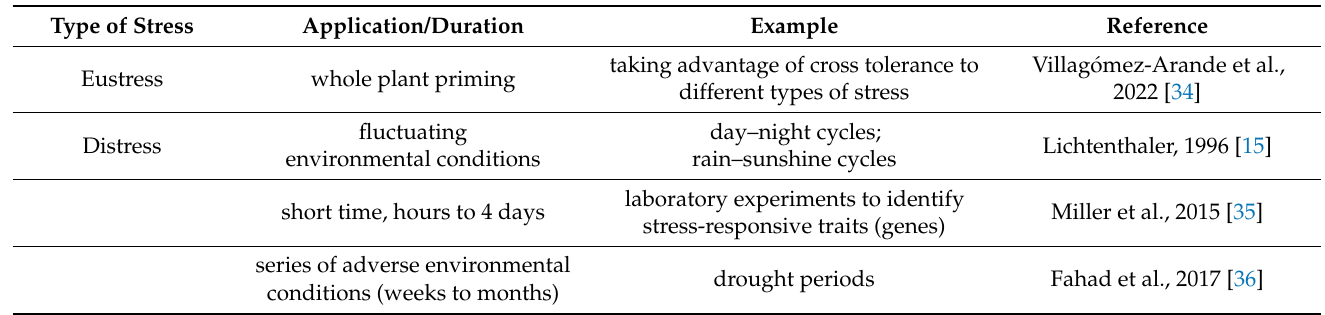
Table 1. Plant response to environmental